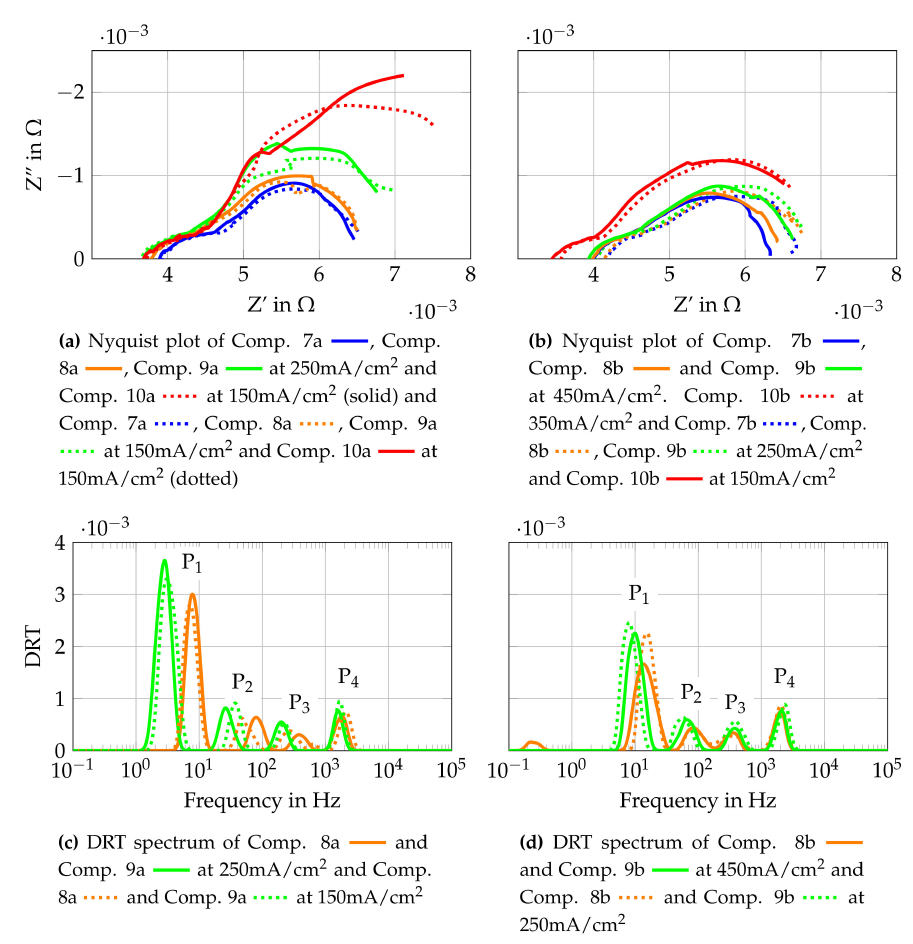
Figure 13. Cell characterization with gas mixtures for internal reforming of